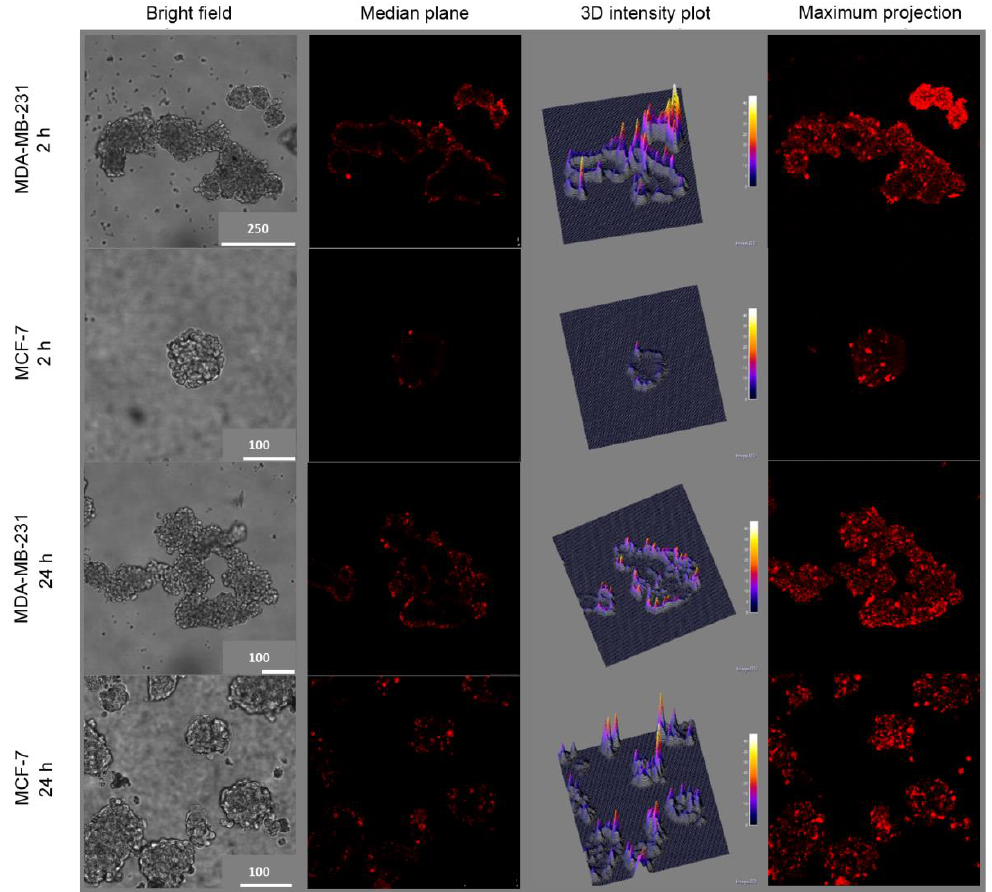
Figure 5. Uptake of HA@TPCS 2a -NPs in MDA-MB-231 and MCF-7 first generation mammospheres incubated for 2 or 24 h with 50 μg/mL HA@TPCS 2a -NPs (TPCS 2a dose 1.25 μg/mL). Column 1: Bright field images; Column 2: TPCS 2a fluorescence at the equatorial plane of mammospheres; Column 3: Three-dimensional reconstruction of TPCS 2a fluorescence distribution and intensity in the equatorial plane of the mammospheres; Column 4: Maximum projection obtained from the superimposition of 20 different acquired focal planes. Scale bar unit in the images is µm.